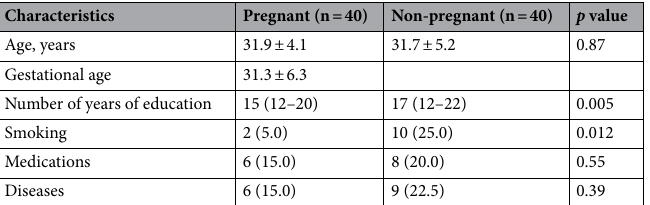
Table 1. Selected women characteristics according to the study groups. Data are presented as mean ± SD, median (range), or n (%).